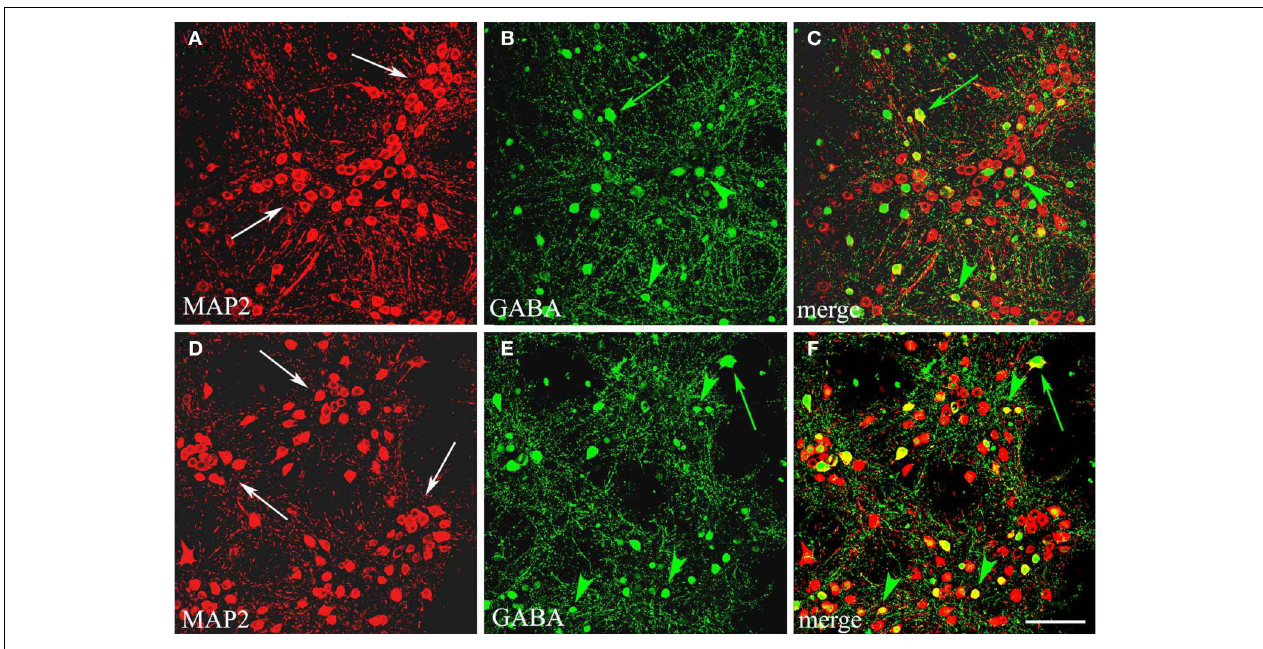
fi elds, where GABA immunocytochemistry (B,E) selects inhibitory neurons (yellow signal in merge, C and F ). Large GABAergic cells (green arrows) are preferentially localized among clusters, whereas small GABAergic cells (green arrowheads) lie also inside these neuronal groups. Scale bar: 67 µm.